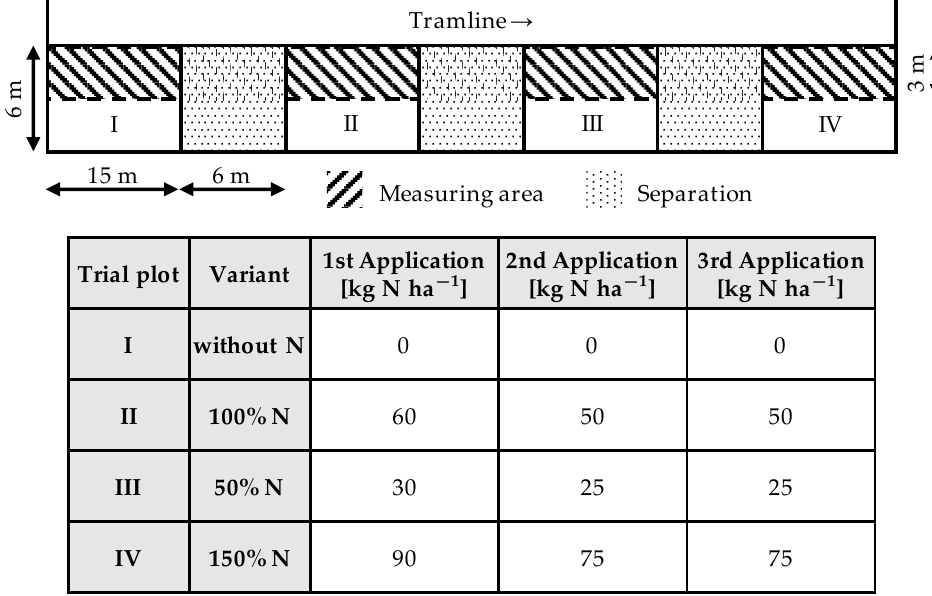
Figure 2. Experimental setup ( top ) and fertilizer rates per application ( down ). The experimental field had a total area of 468 m² and homogeneous soil conditions.